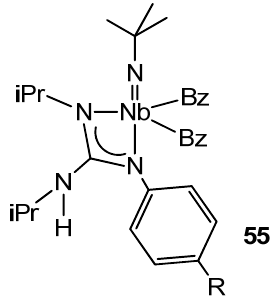
Figure 33. Asymmetric coordination of a guanidinato ligand in niobium complexes.